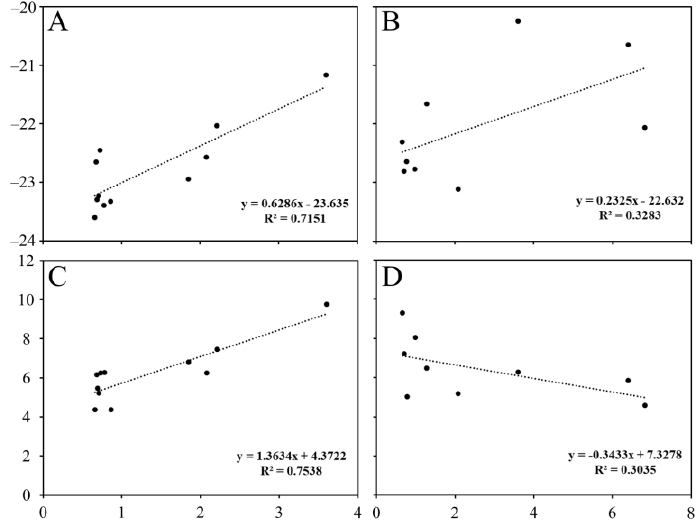
Figure 5. Mean prosome length versus δ 13 C and δ 15 N values of copepods in the south ( A , B ) and north regions ( C , D ) of the subpolar front.